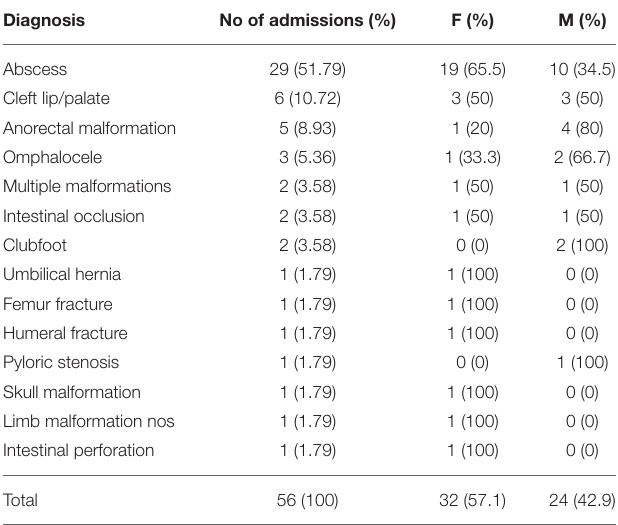
TABLE 2 | Surgical diagnosis made in the Neonatology Department of Mutoyi Hospital